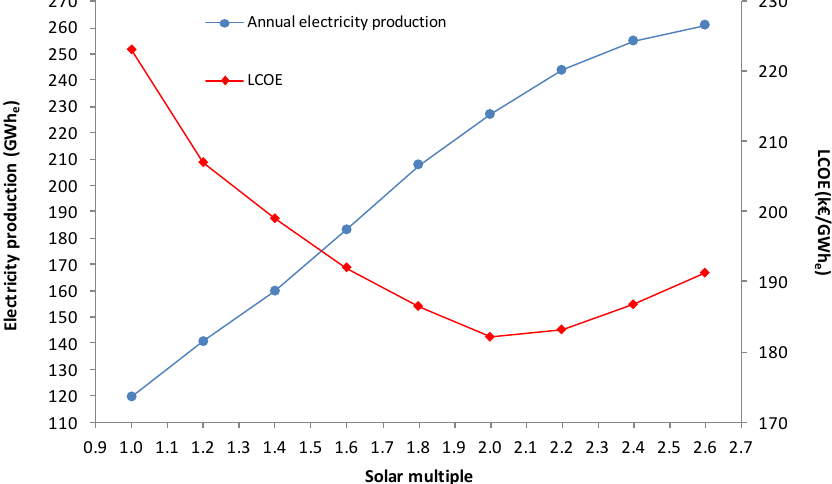
Figure 10. Annual net electricity generation and LCOE as SM function for Area 2, Posadas.